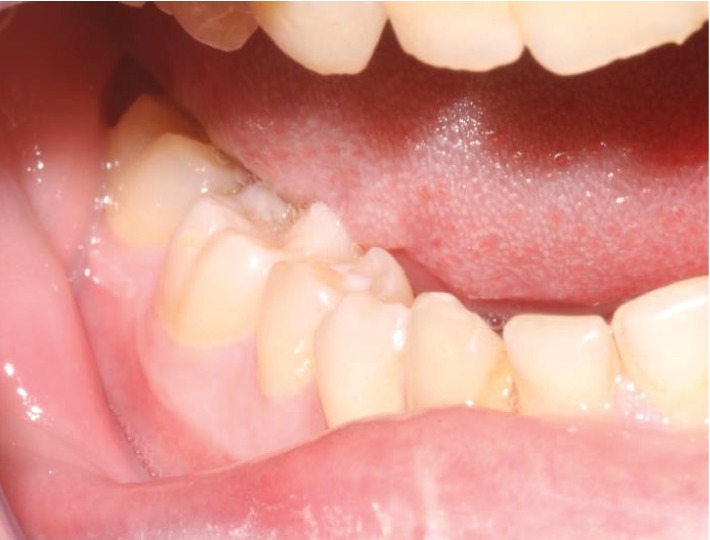
Preop intraoral photo. Buccal bony expansion is appreciated on manual palpation.